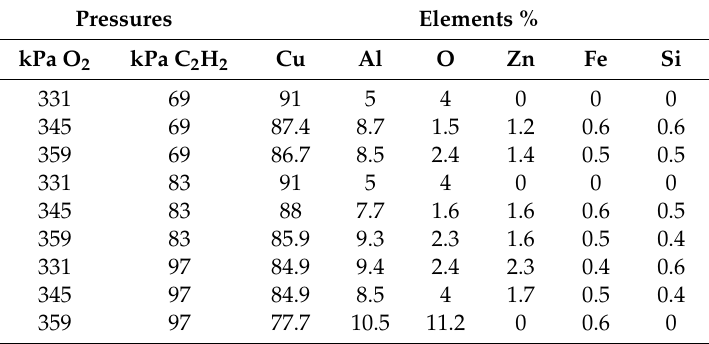
Table 2. Approximate elementary composition of Cu-Al coatings samples obtained via energy-dispersive spectroscopy